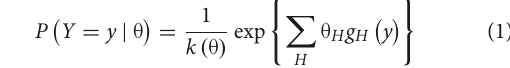
Benchmark tendency of relationship